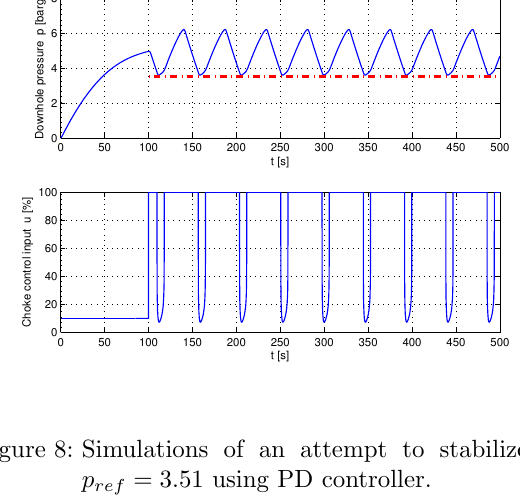
Figure 8: Simulations of an attempt to stabilize at p ref = 3 . 51 using PD